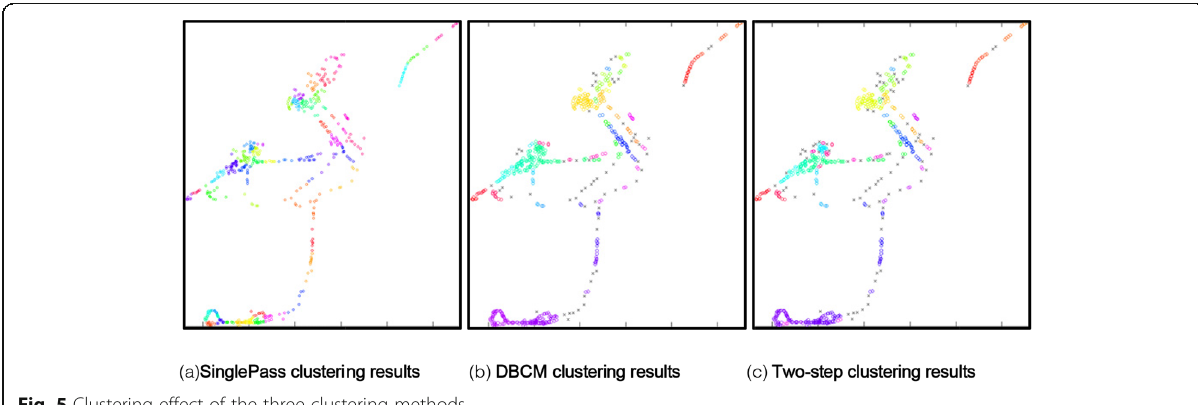
Fig. 5 Clustering effect of the three clustering